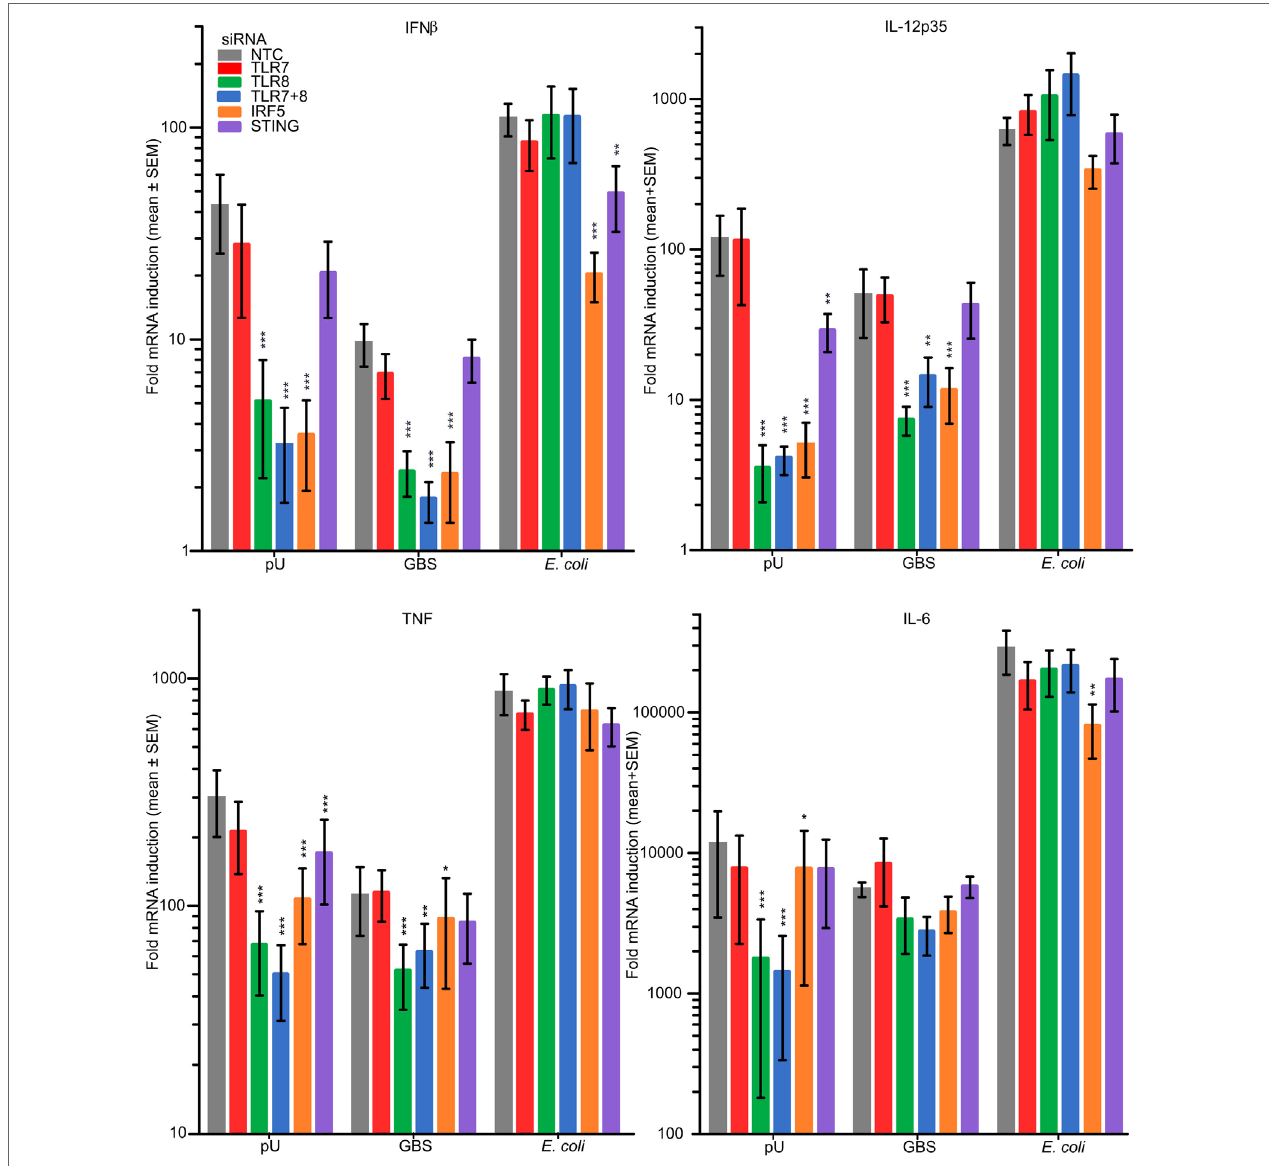
FigUre 7 | Group B Streptococcus (GBS) trigger cytokine production in part via TLR8-IRF5 signaling, while Escherichia coli induces cytokines independently of TLR8, yet partly dependent on IRF5. Monocyte-derived macrophages (MDM) were transfected with siRNA against TLR7, TLR8, IRF5, and STING, as indicated. Following successful silencing the cells were stimulated with pU/pLA or infected with viable GBS wt (MOI 1.0) or E. coli (MOI 2.0) . Cytokine induction relative to non-stimulated cells after 4 h of infection was determined by quantitative real-time PCR (qPCR). Significance of gene silencing was tested in relation to non-targeting control (NTC). n =